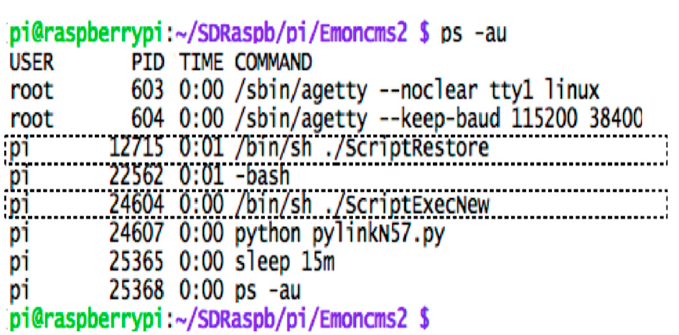
Figure 8. The main scripts running in the gateway. Sensors 2018 , 18 , x